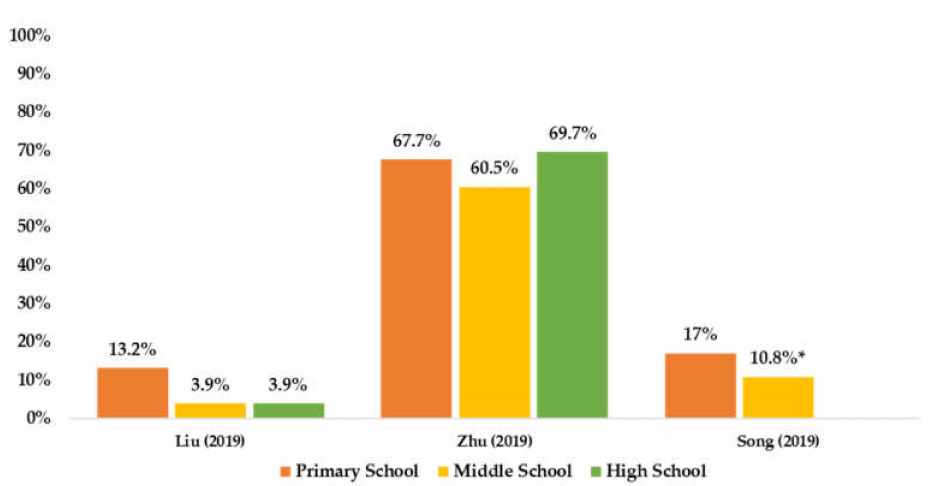
Figure 5. Summarized available prevalence of SB by age groups among Chinese children and